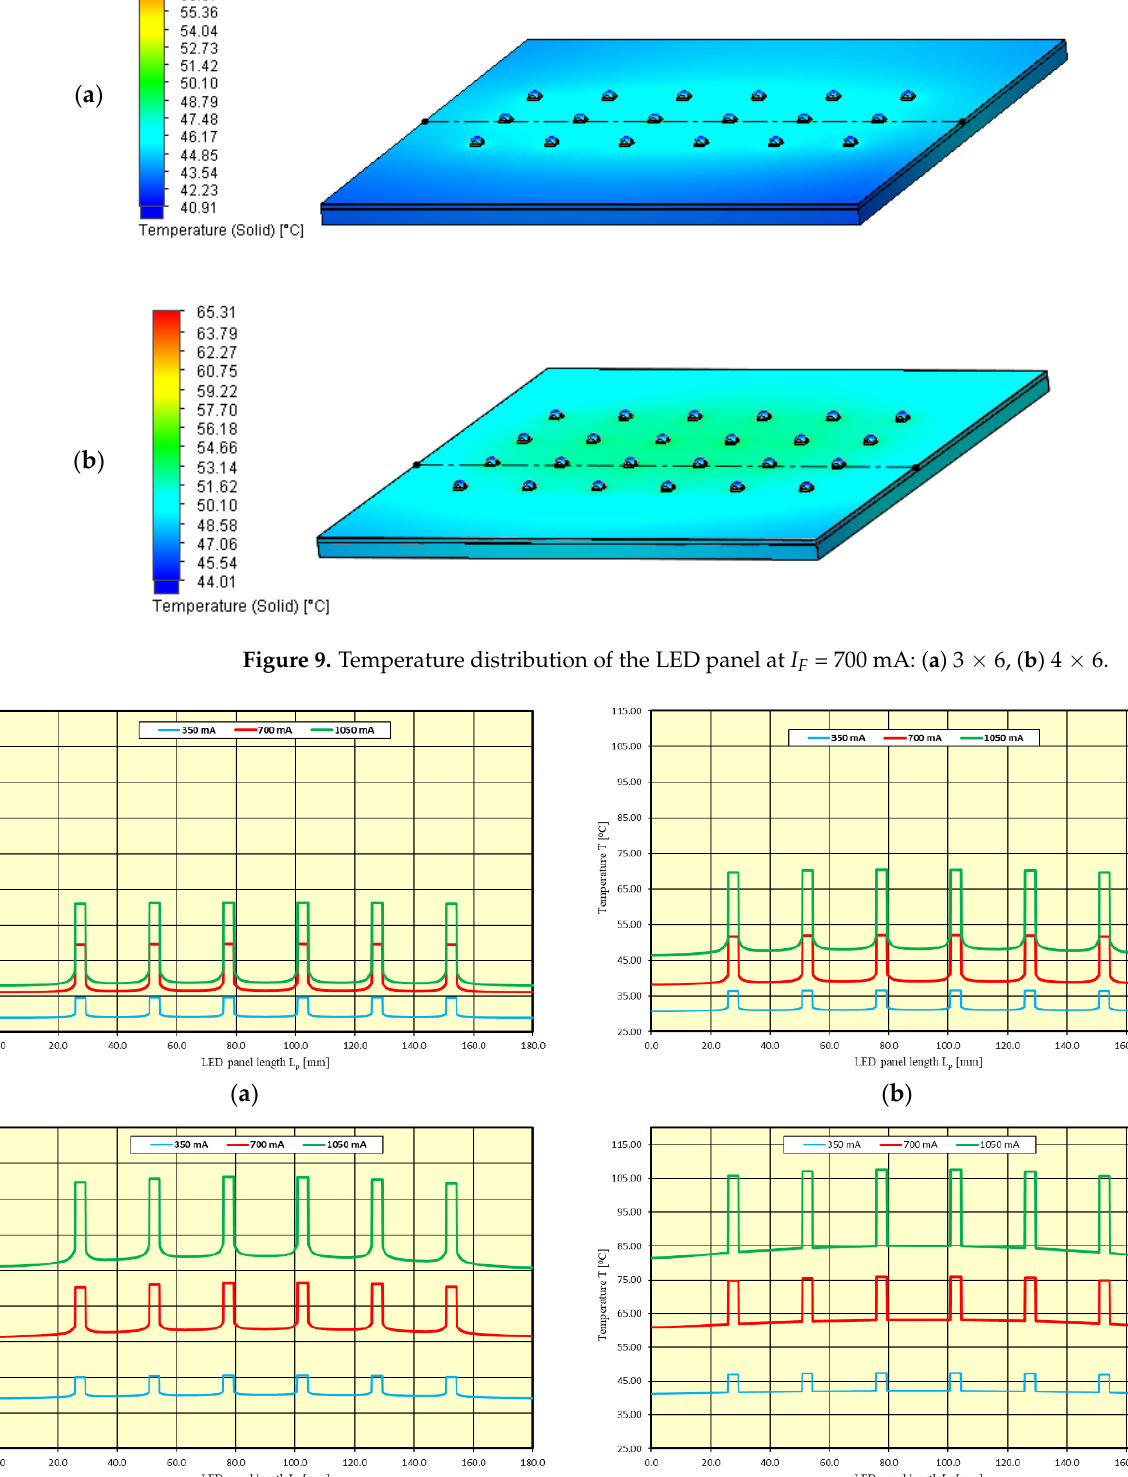
Figure 8. 6 × 1 LED panel, I F = 700 mA: ( a ) temperature distribution for the tested panel, ( b ) deter- mined junction temperature T j of individual LEDs.